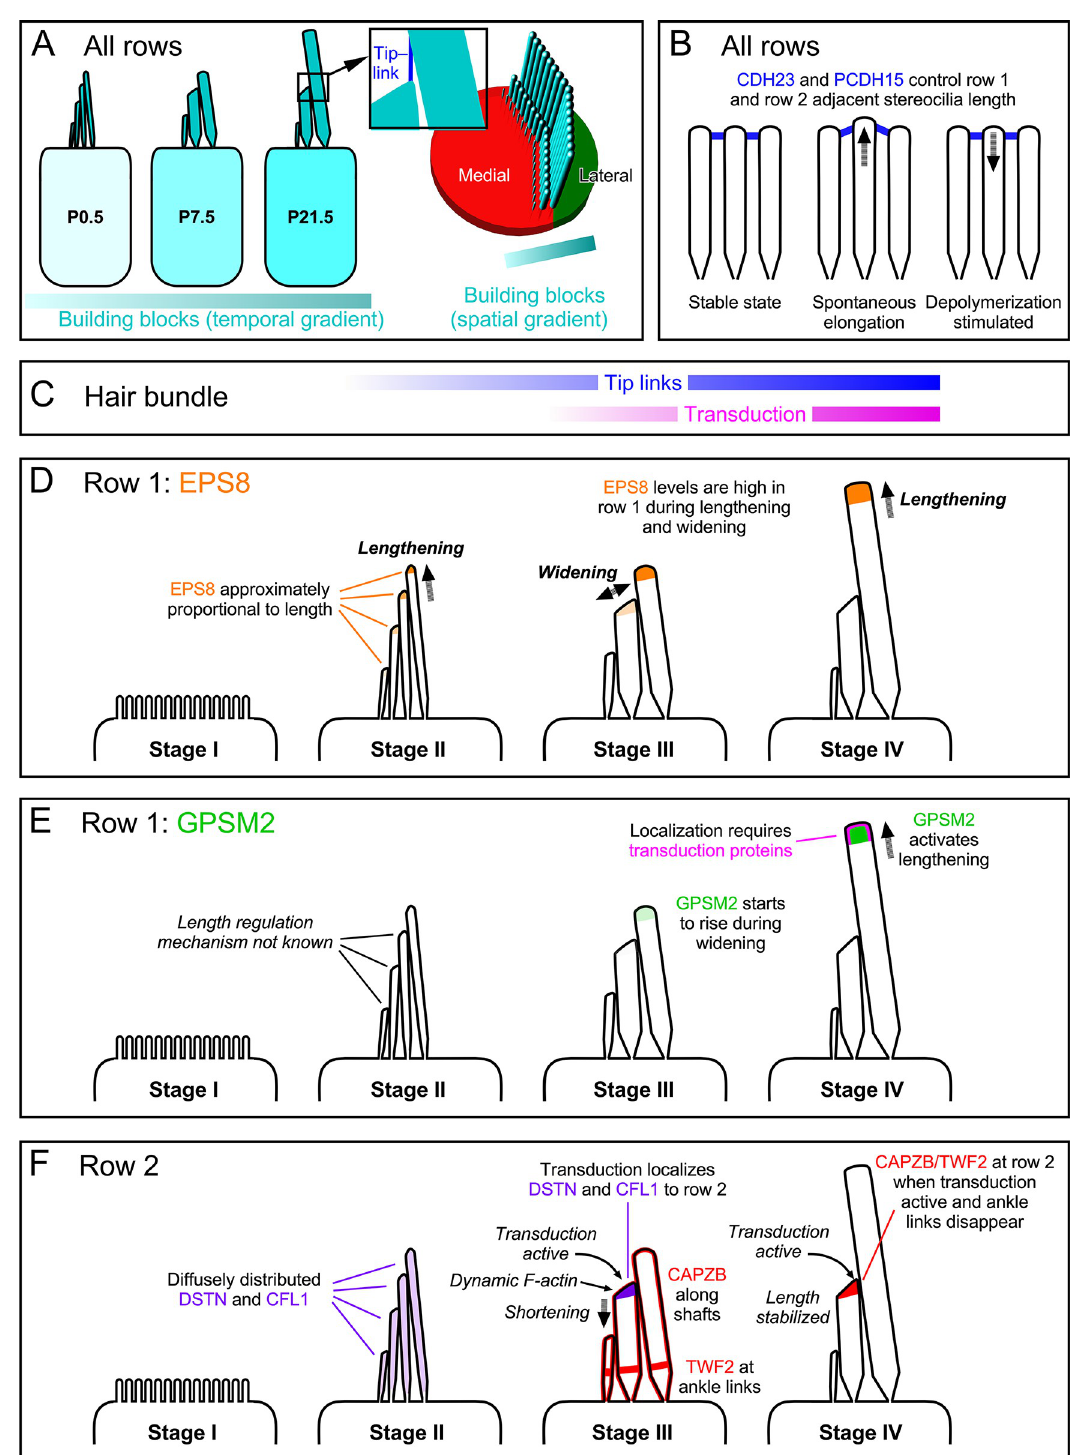
Fig 15. Model for assembly of IHC hair bundle. ( A ) Left, stereocilia building blocks (combined actin and actin crosslinkers) increase continuously in IHCs throughout early postnatal development. Right, a spatial gradient of building blocks may also exist, with building blocks having greater access to row 1 stereocilia than to shorter rows. ( B ) PCDH15 and CDH23 maintain coordination of adjacent stereocilia lengths, presumably by triggering actin depolymerization when spontaneous stereocilia elongation interrupts the stable state. ( C ) Timing of tip-link and transduction appearance relative to stages depicted in panels D–F. ( D–F )